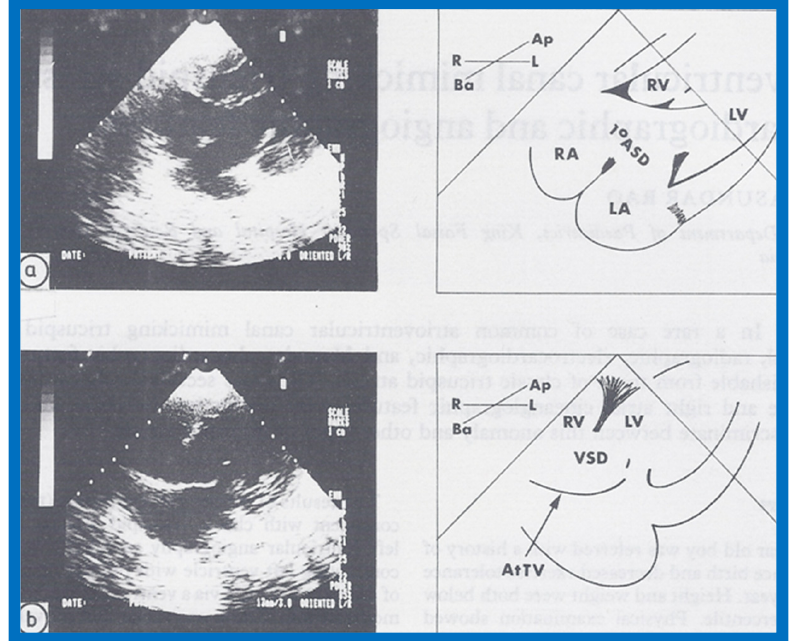
Figure 50. Selected two-dimensional, subcostal, four-chamber echocardiographic frames with an open ( a ) and closed ( b ) atrioventricular valve. Line drawings on the right of a and b are made for greater clarity and for labeling. A large ostium primum atrial septal defect (1 0 ASD) is shown in a. When the large atrioventricular valve leaflet is open ( a ), it completely closes the right ventricle (RV) from the right atrium (RA) and ventricular septal defect (VSD) and allows emptying of blood from both atria into the left ventricle (LV). When atrioventricular valve leaflet is closed ( b ), it continues to occlude the RV from the RA while allowing the VSD to freely communicate between RV and LV. Ap, Apex; AtTV, atretic tricuspid valve; Ba, base; L, left; LA, left atrium; R, right. Reproduced from Rao P.S. [15].